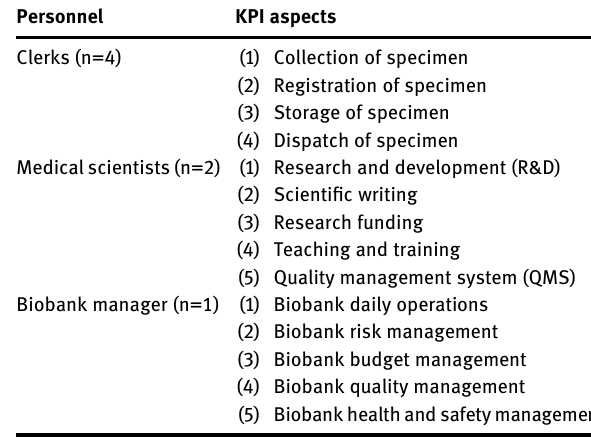
Table  : Biobank personnel and their respective